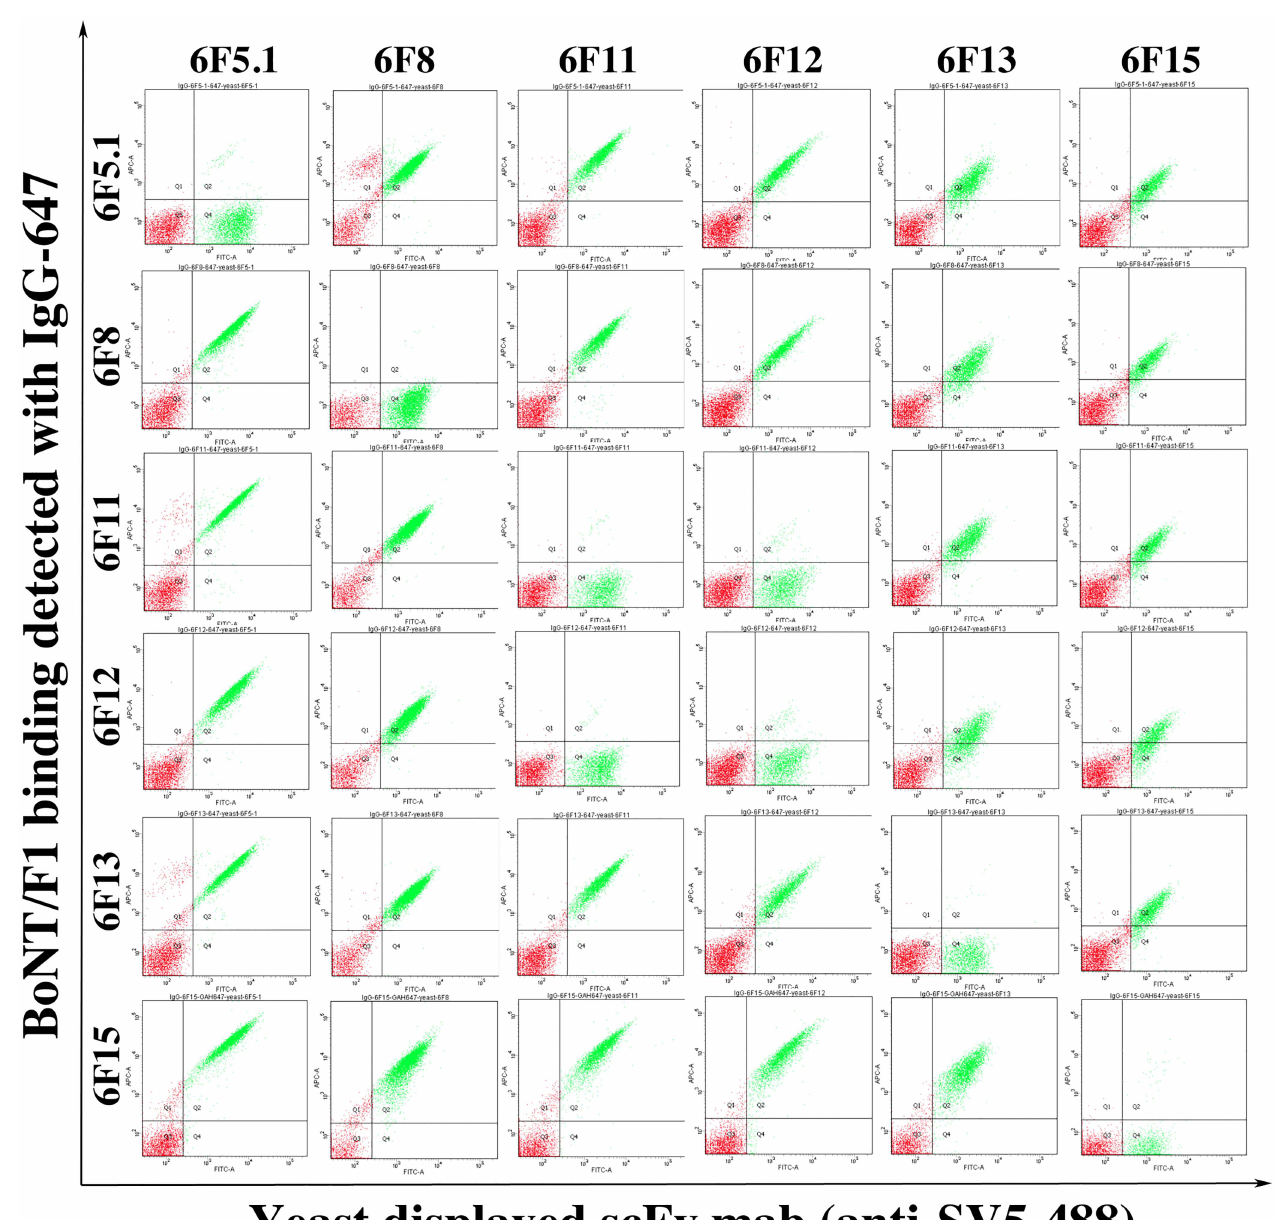
Fig 3. Identification of overlapping and non-overlapping mAb epitopes. Yeast-displayed scFv were incubatedwith BoNT/F1 holotoxin, followedby incubation with one of six Alexa-647labeledIgG and Alexa-488labeledanti-SV5 IgG. mAbs with non-overlapping epitopeshoweda signalin the